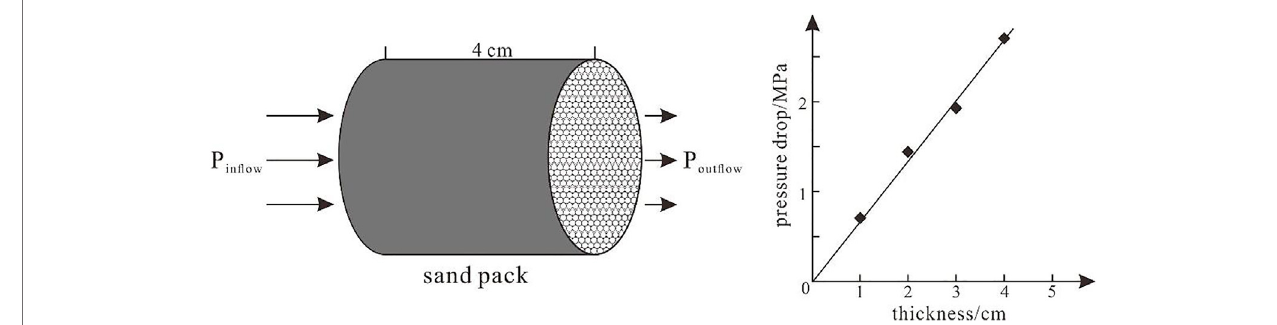
FIGURE 4 | Pressure drop test results from fi lling thickness on gas fl ow.